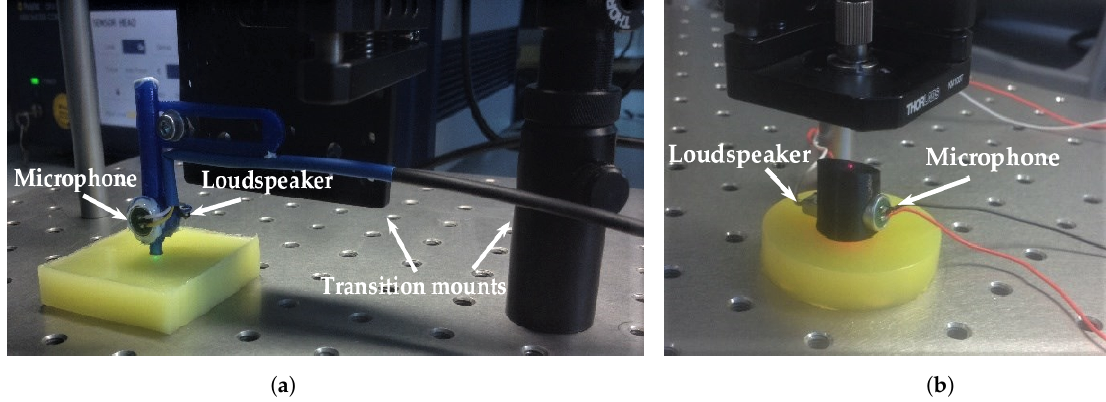
Figure 1. Picture of the experimental setup; ( a ) with the smaller pipette, ( b ) with the bigger